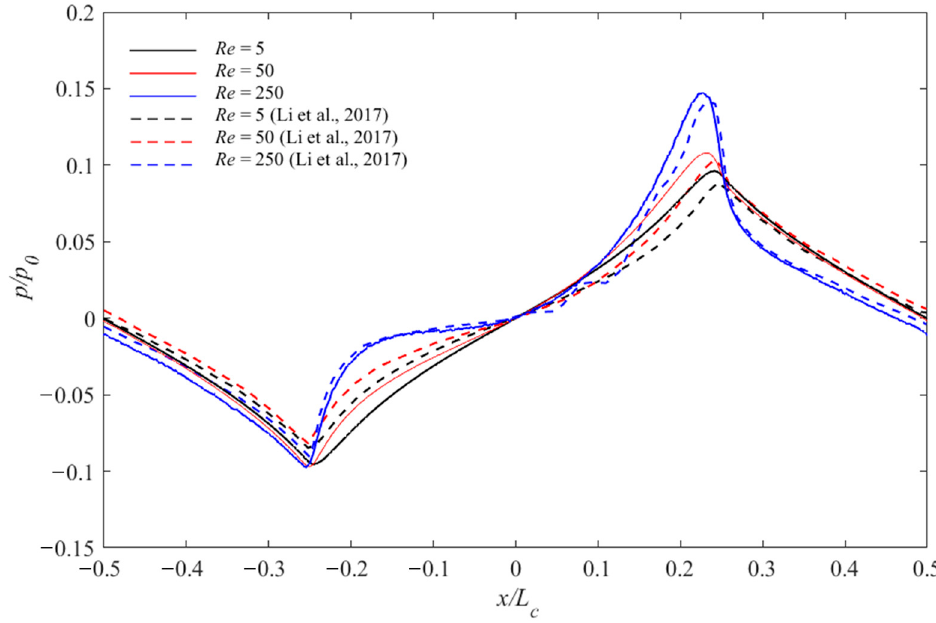
Figure 6. Static pressure distribution on the middle section of the micro-pocket unit at different Reynolds numbers [38].